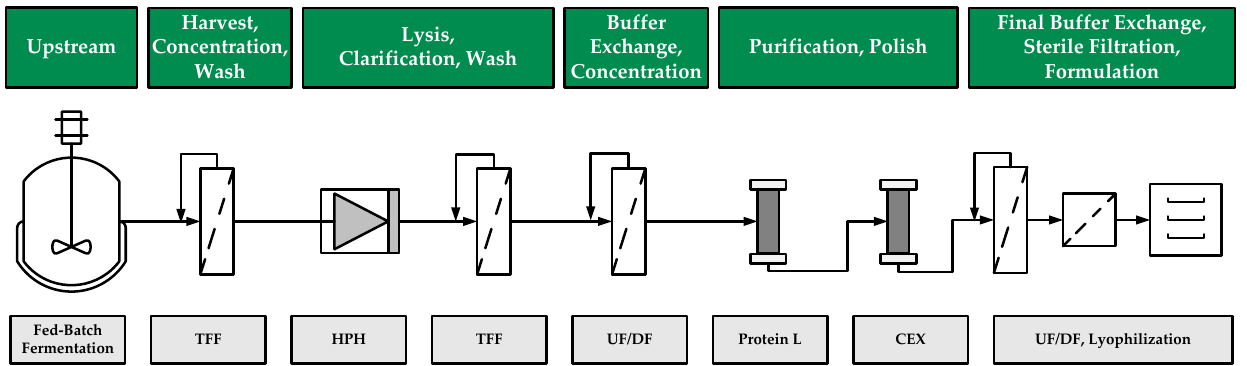
Figure 3. Process overview of the production of scFv. The process starts with fermentation of E. coli . Cells are harvested and washed by TFF, and subsequently lysed through HPH to release the intracellular product. The scFv is leached by TFF, concentrated and buffer exchanged by UF/DF and finally purified and polished through Protein L and CEX chromatography, respectively. Fill-and-finish is done by buffer exchange and